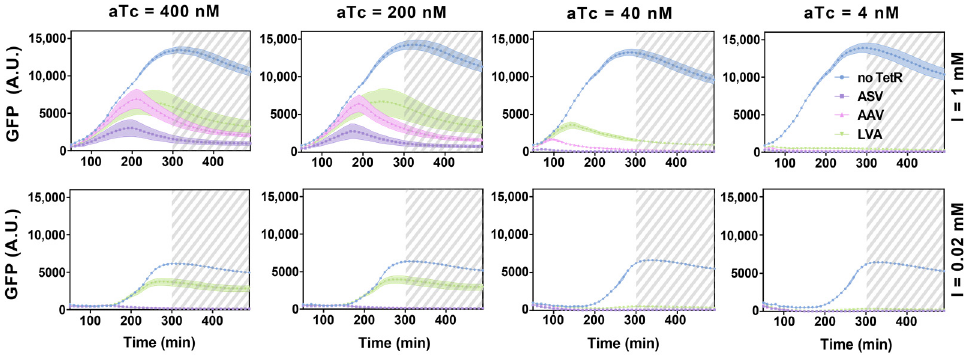
Figure 7. Experimental results for RNA–protein hybrid circuit. Time course measurement of GFP fluorescence for different inducer concentrations; IPTG concentrations at 1 mM and 0.02 mM; aTc concentrations at 400 nM, 200 nM, 40 nM and 4 nM. Y is represented by different symbols; no TetR by blue circles, TetR-ASV by purple squares, TetR-AAV by pink triangles, and TetR-LVA by green triangles. Data for the first 50 min were removed due to low OD600 values, and the time points beyond 300 min are marked as gray dashed area to indicate the transition to stationary phase. The letter ‘I’ represents IPTG. Relative errors for GFP fluorescence are from the s.d. of six biological replicates.